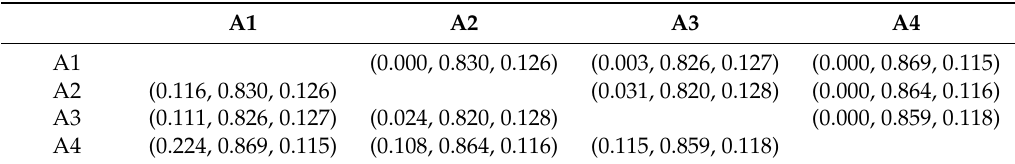
Table 8. The preference index of the four